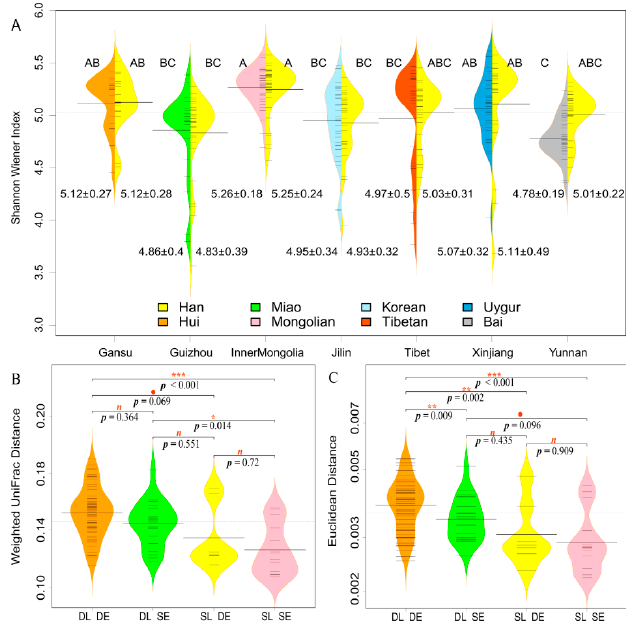
Figure 2. ( A ) Beanplot of the Shannon Wiener index. Different letters mean significant difference at the 5% level, and the same letter means no significant difference. From “A” to “C” , the Shannon Wiener index decreased significantly . Tail of each plot notes mean value ± standard deviation. ( B ) and ( C ) show, respectively, the difference of weighted UniFrac distance of operational taxonomic units (OTUs) and the Euclidean distance of KOs among different combinations with geographic location and ethnicity (at the X -axis, DL = Different Location; SL = Same Location; DE = Different Ethnicity; SE = Same Ethnicity); “ p ” represents p -value of Tukey tests between two groups connected by horizontal lines. ***: p < 0.001; **: 0.001 ≤ p < 0.01; *: 0.01 ≤ p < 0.05; ● : 0.05 ≤ p < 0.1; n: p ≥ 0.1, not significant.